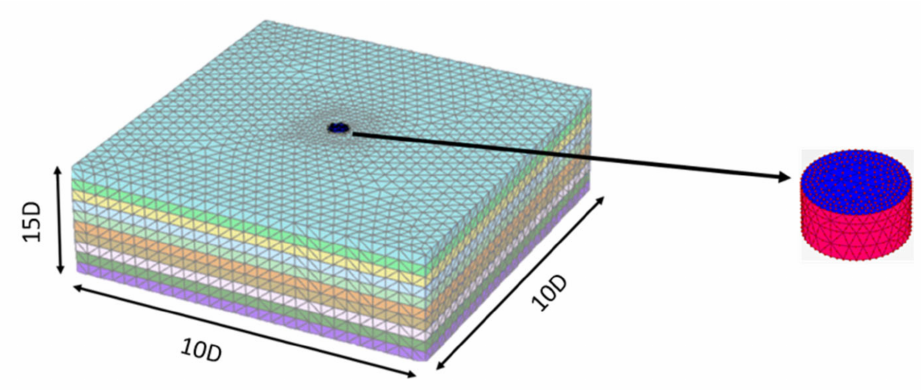
Figure 5. Mesh dimensions and shape of